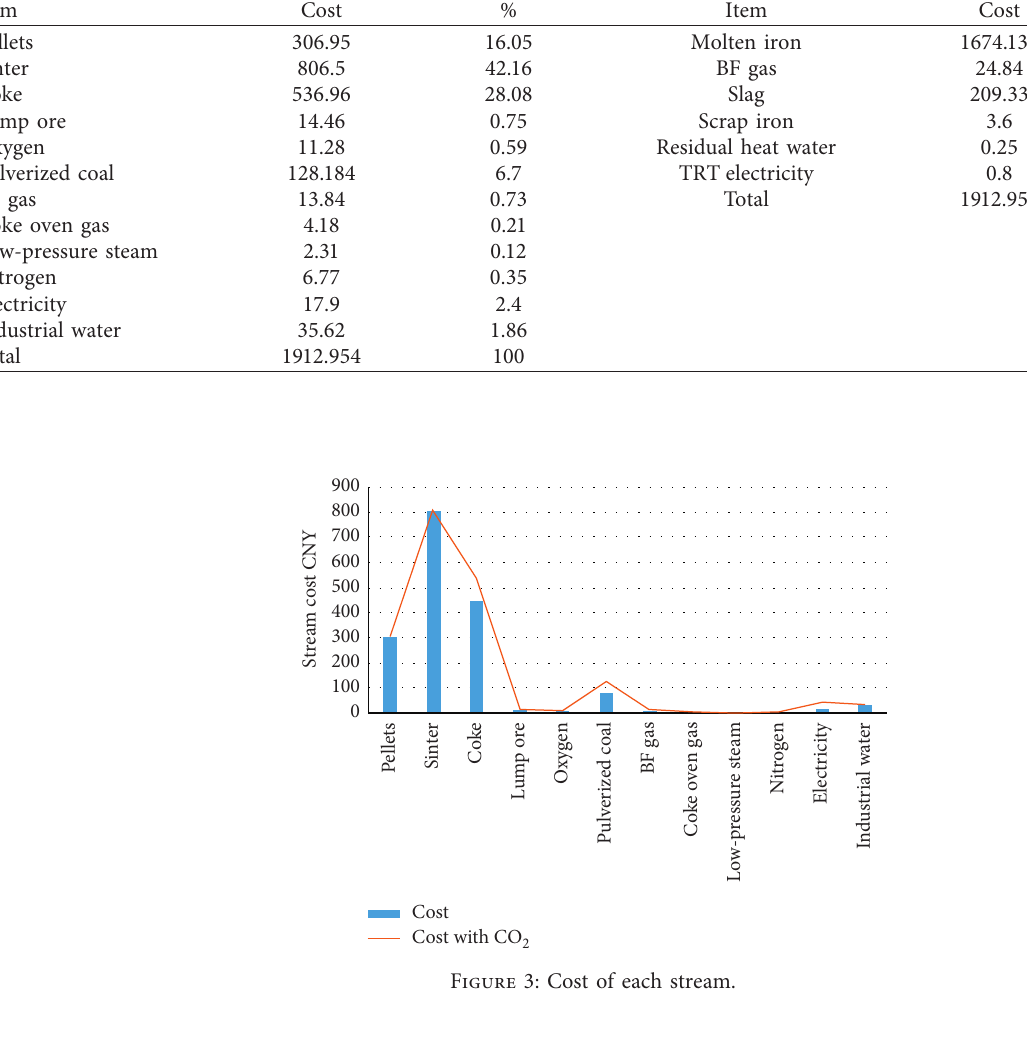
2 of the ironmaking system.